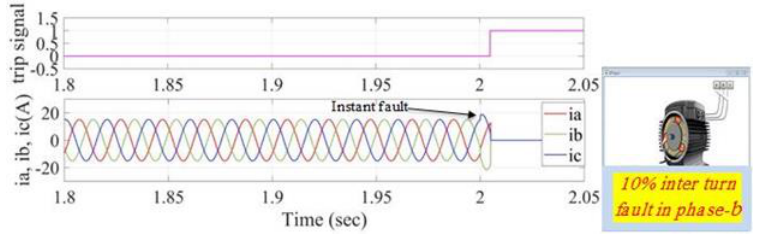
Figure 19. Stator current and trip signals for 10% inter-turn fault in phase-b (application of the pro- posed method when it uses its non-overlapping window frame algorithm).